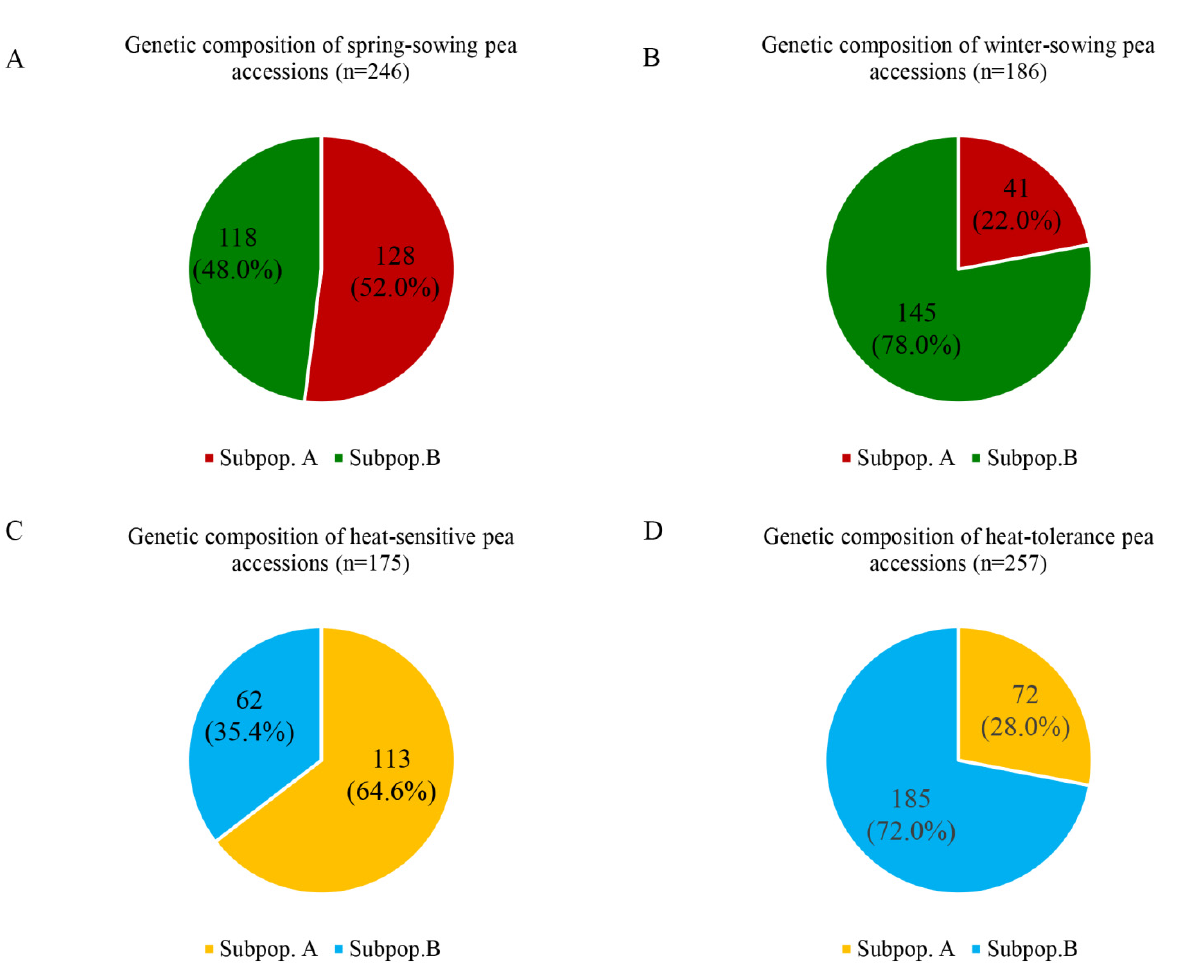
Figure 8. Population genetic structure of 432 pea accessions after HTS1. Genetic composition of ( A ) spring-sowing pea accessions ( n = 246) and ( B ) winter-sowing pea accessions ( n = 186), with 46 neutral SNaPshot markers. Genetic composition of ( C ) heat-sensitive pea accessions ( n = 175) and ( D ) heat-tolerant pea accessions ( n = 257), with 20 heat-tolerance-related SNaPshot markers.